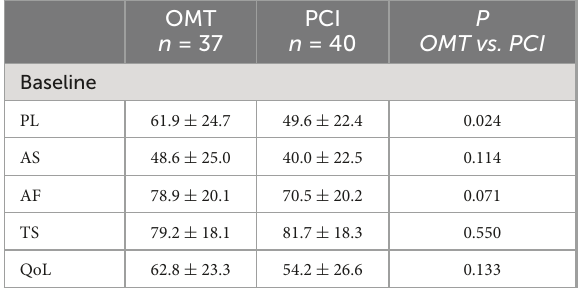
TABLE 4 Seattle angina questionnaire health status at baseline.